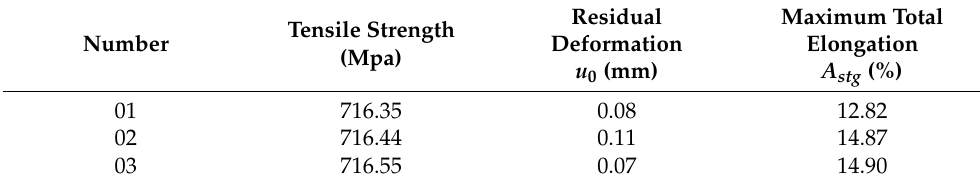
Table 1. Joint performance